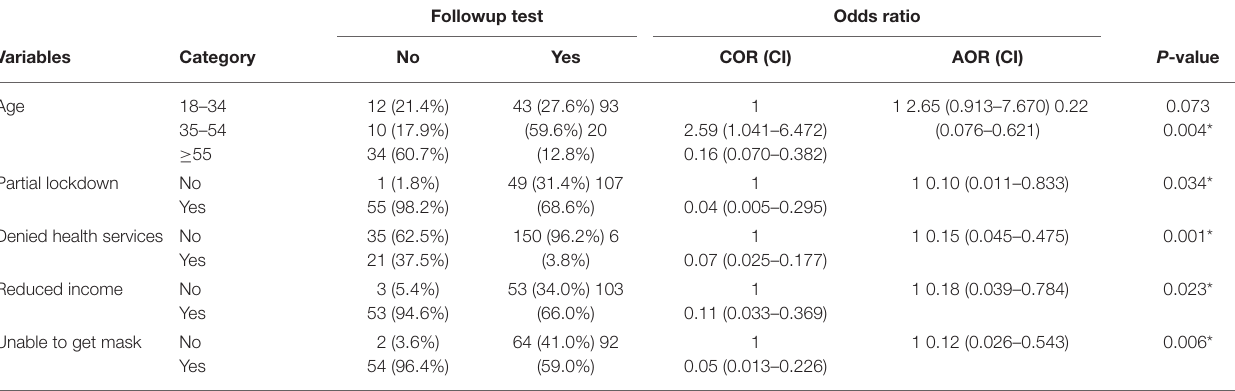
TABLE 9 | Bivariate and multivariate logistic regression analysis of the follow-up tests variable, Addis Ababa, Ethiopia,